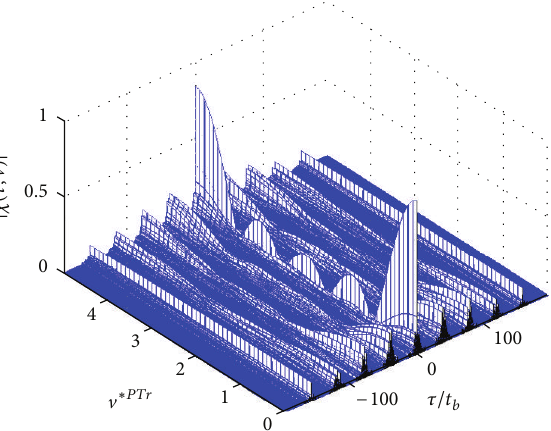
Figure 5: Ambiguity function of COCS P4 MCPC pulse